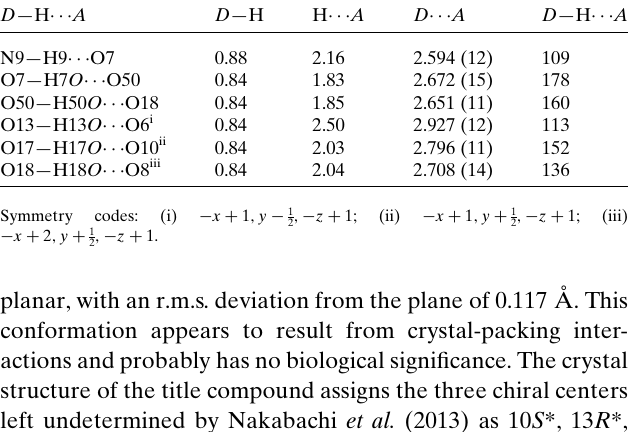
Table 1 Hydrogen-bond geometry (A˚ , (cid:3) ).